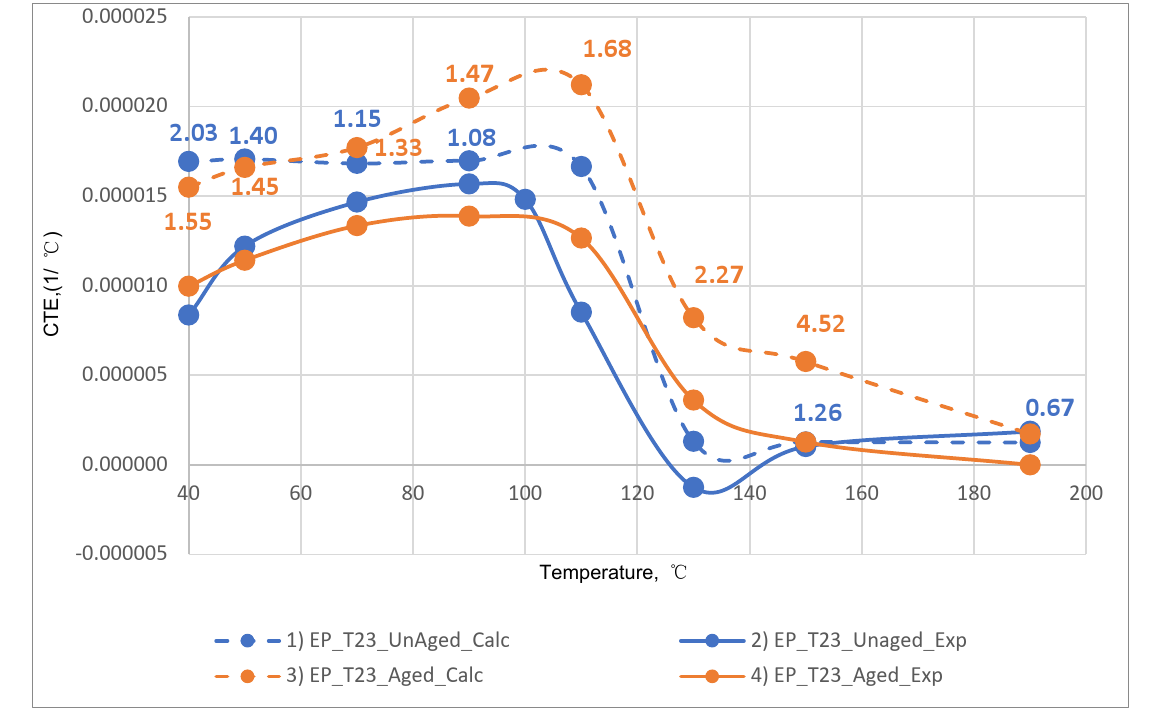
Figure 19. Dependence plotted from the averaged CTE values on temperature for epoxy fiberglass on glass fabric T-23: (1) calculated for EP-T23; (2) experimental for EP-T23; (3) calculated for EP-T23-TA; (4) experimental for EP-T23-TA.